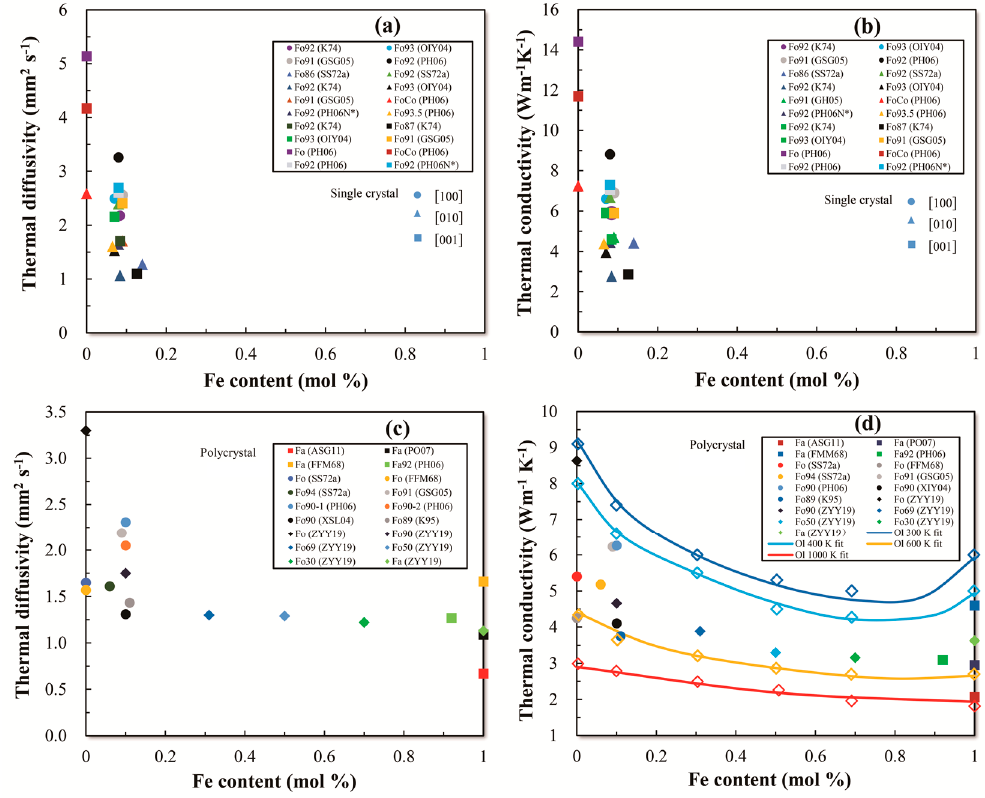
Figure 5. Effect of Fe content on D and κ in single crystal and polycrystalline olivine. ( a ) and ( c ): D . ( b ) and ( d ): κ . The influence of scattering by solute atom on the κ under various temperatures is modeled using the model proposed by Padture and Klemens [69]. This model predicts the κ of olivine with any Fe content.